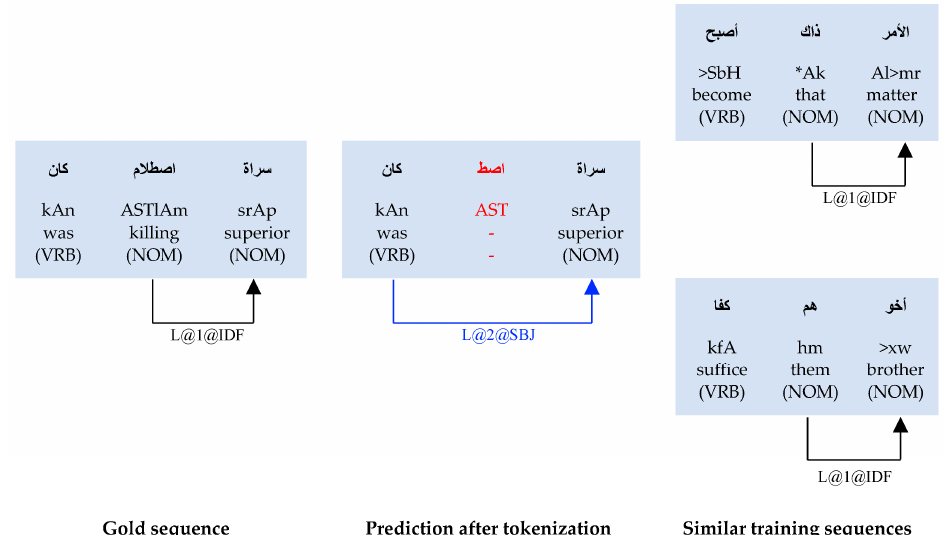
Figure 9. Example of syntactically wrong labeling caused by poor tokenization. The blue arrow represents an incorrect prediction. The word highlighted in red displays an incorrect tokenization.